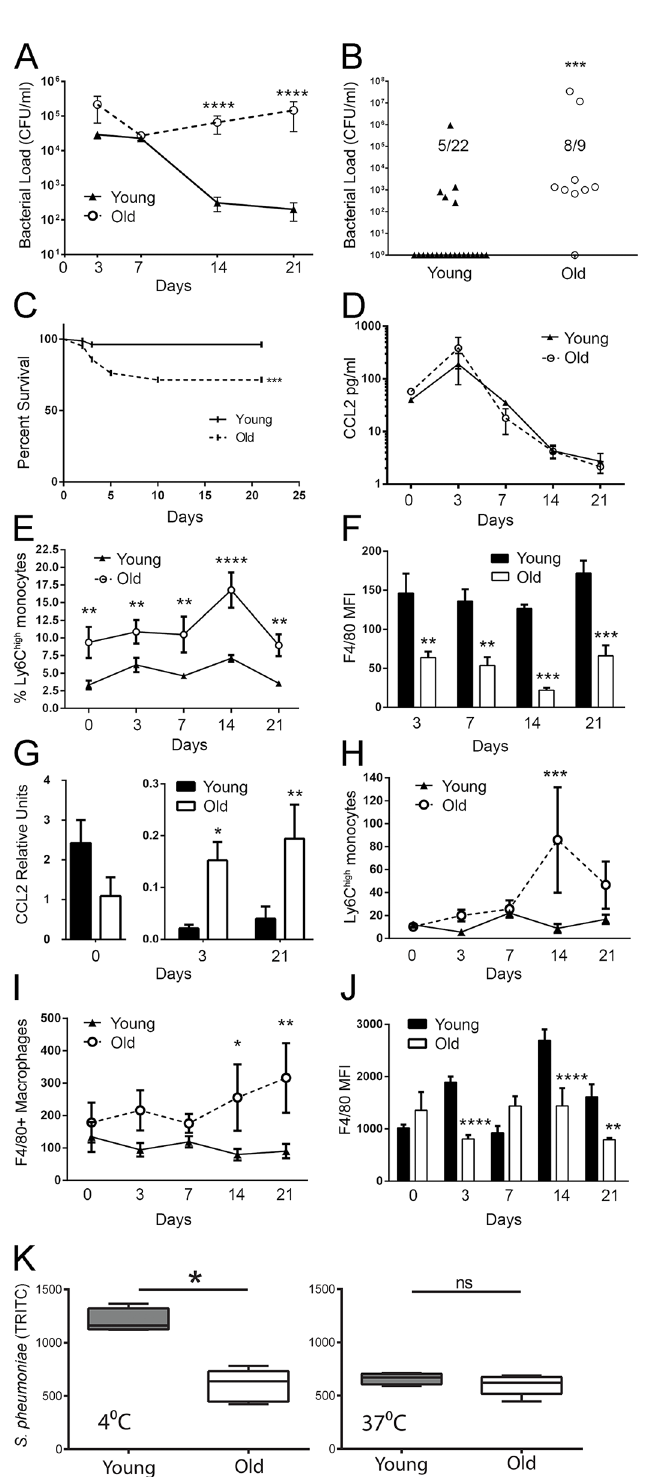
Fig 6. Old mice have increased numbers of circulating and recruited Ly6C high monocytes during the course of S . pneumoniae colonization. (A) Colony forming units (CFUs) in nasal lavages from young and old WT mice were quantified on days 3, 7, 14 and 21 following intranasal colonization with S . pneumoniae ( ± SEM; n = 5 – 22). (B) CFUs of S . pneumoniae in the lungs at day 3 following intranasal colonization ( ± SEM; n = 9 – 22). (C) Survival of young and old mice after intranasal S . pneumoniae colonization ( ± SEM; n =